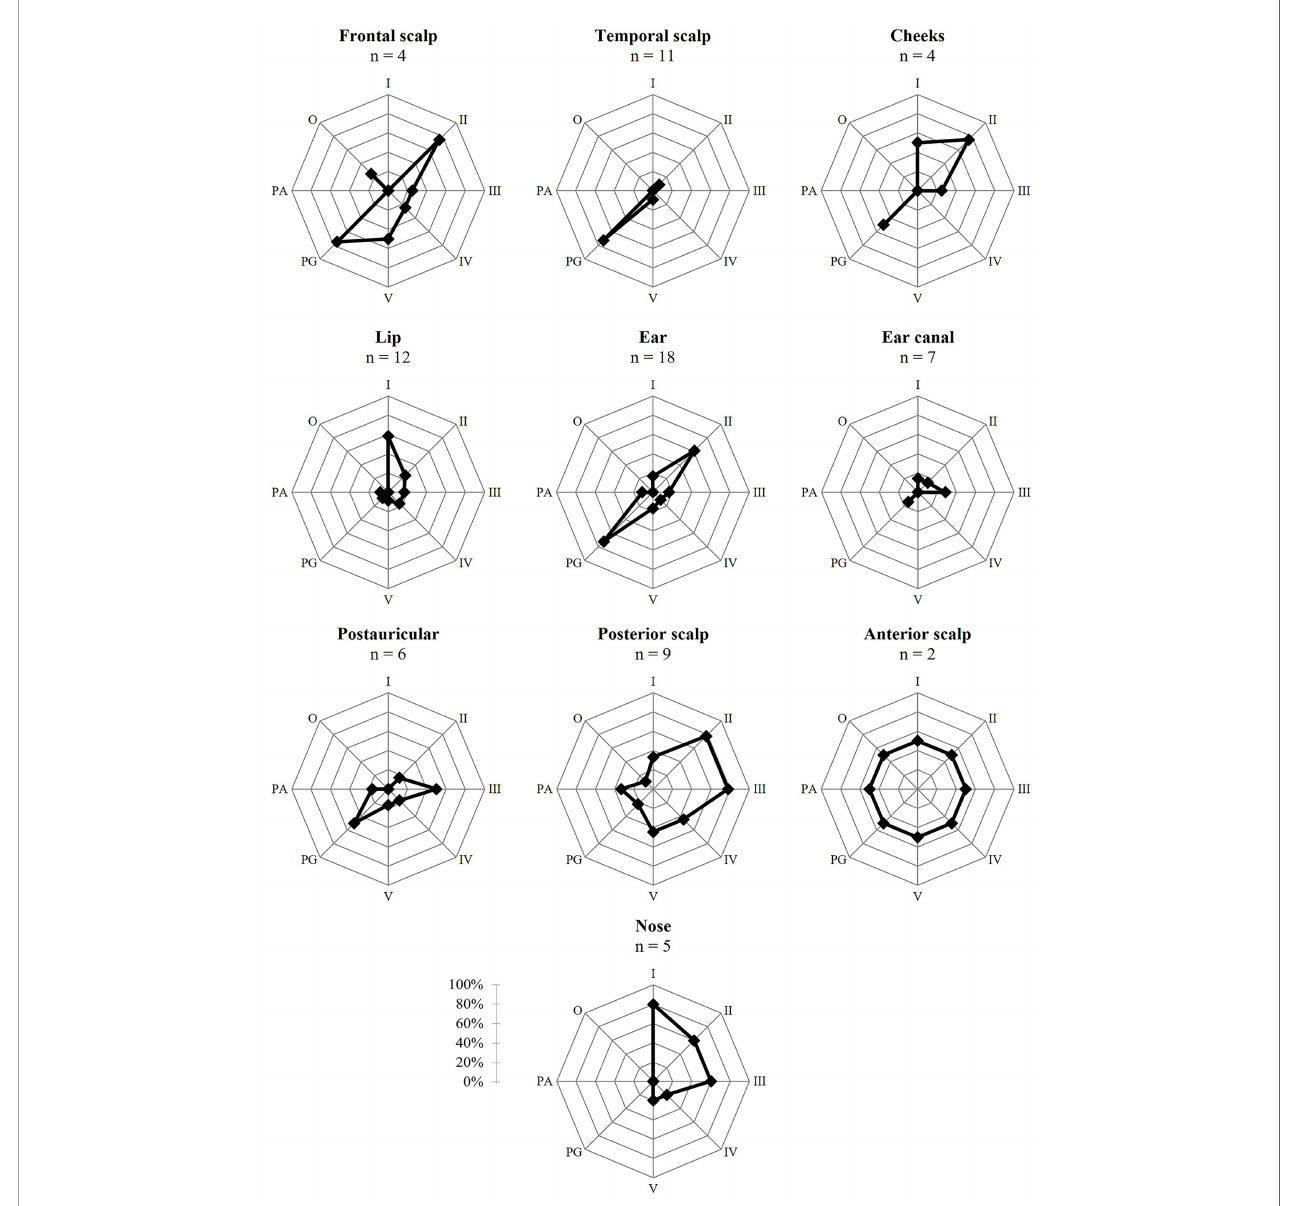
FIGURE 3 | Risk ratio in percentages of tumor metastasis per location per level. Locations with n = 1 are not included; I, level 1; II, level 2; III, level 3; IV, level 4; V, level 5; PG, parotid gland; PA, postauricular; O,